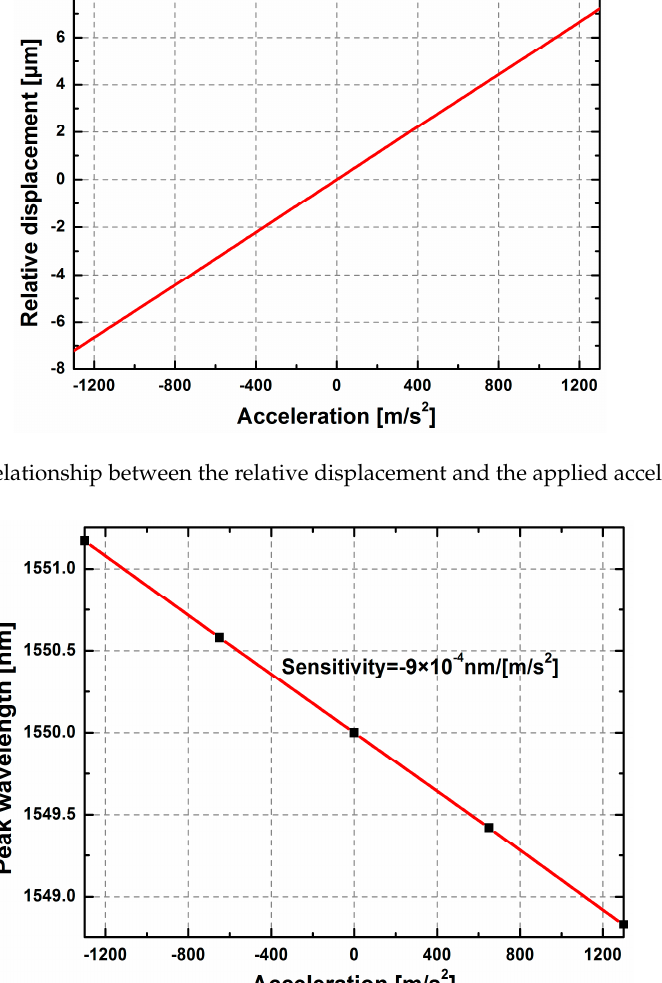
Figure 10. Relationship between the peak wavelength of ROTE transmission and the applied acceleration.